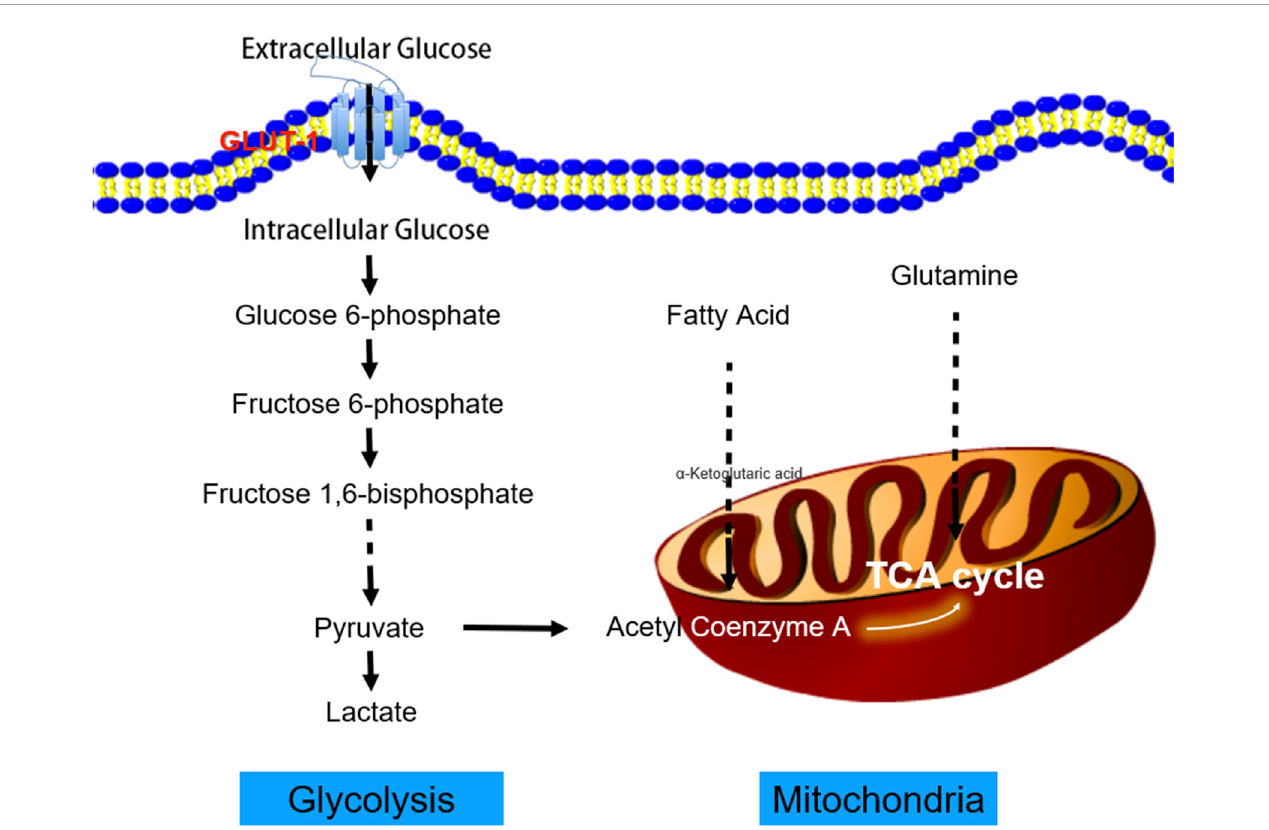
FIGURE 1 The process of tumor aerobic glycolysis. Cancer cells increase the uptake of glucose and the production of lactic acid by enhancing aerobic glycolysis. Glucose provides the primary carbon source for the tricarboxylic acid cycle (TCA). Cancer cells use the glycolytic pathway to rapidly produce adenosine triphosphate (ATP) and its intermediate product as a carbon source to synthesize macromolecular compounds, for example, to provide a suf fi cient carbon source for the pentose phosphate pathway to generate 5-phosphate ribose backbone. The reduced nicotinamide adenine dinucleotide phosphate (NADPH) produced by the pentose phosphate pathway can maintain the cell ’ s redox homeostasis. In addition, the lactic acid produced by glycolysis can promote the acidi fi cation of the tumor microenvironment, which is conducive to tumor cell invasion and migration.